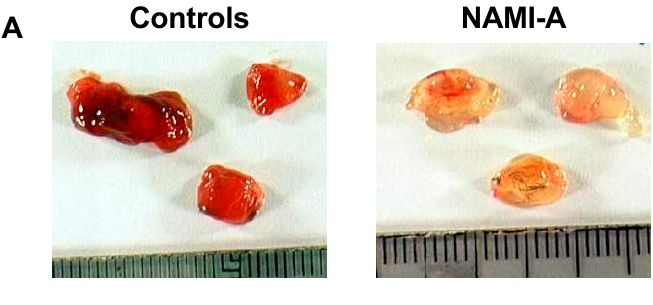
Figure 11. Cont. Figure 11.